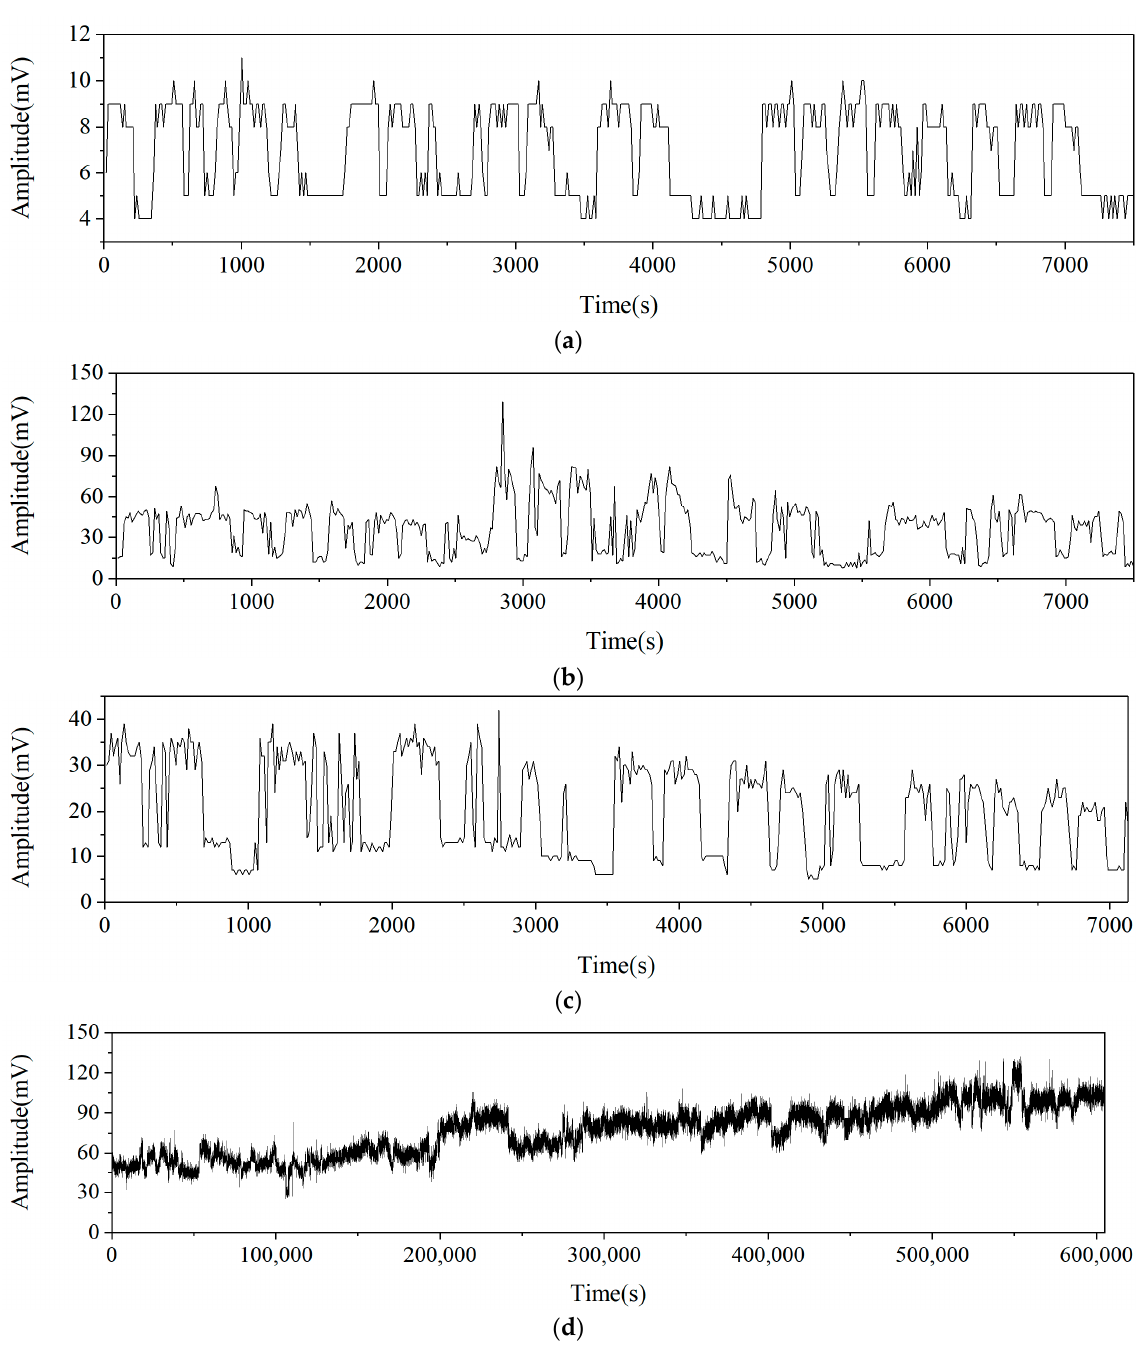
Figure 4. Different types of EMR signals. ( a ) EMR signal of environmental noise (EMR-EN). ( b ) EMR signal induced by drilling (EMR-Drill). ( c ) EMR signal induced by scraper loader (EMR-SL). ( d ) EMR signal with danger of coal and gas outburst (EMR-Danger).